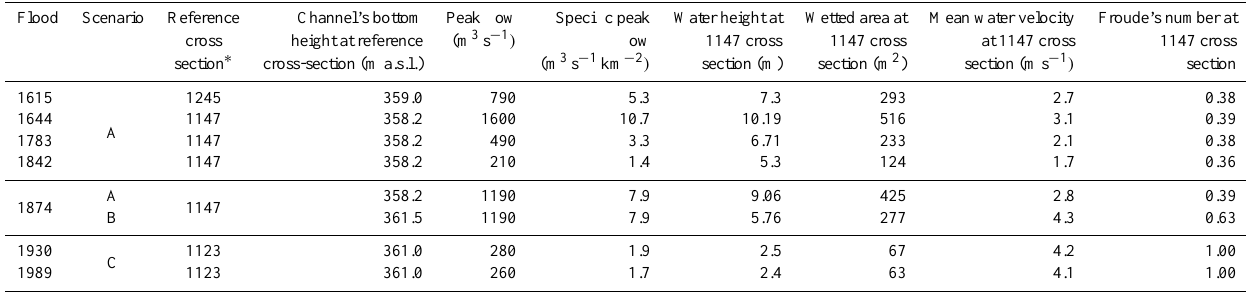
Table 3. Results of the hydraulic modelling at the time of the peak flow.